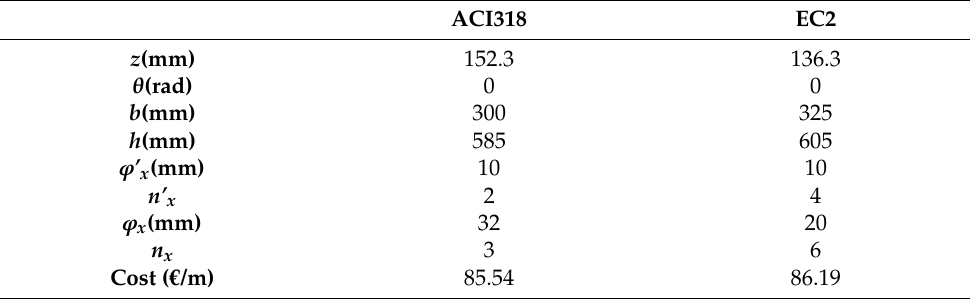
Table 1. Optimal design solutions obtained using the MPFA.